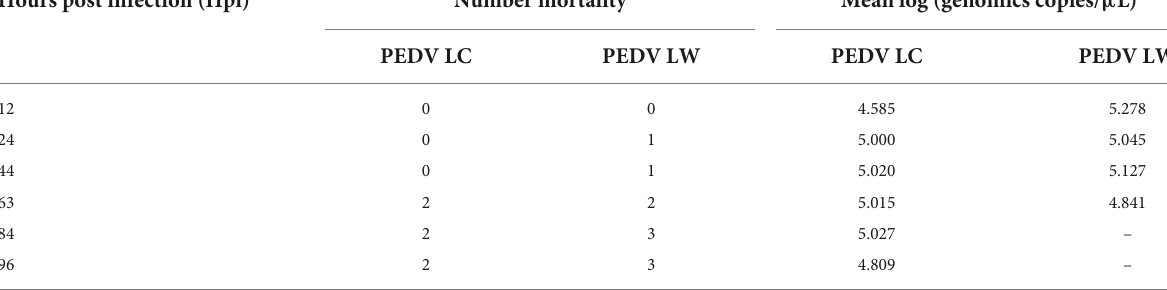
TABLE 5 Mortality and viral load of porcine epidemic diarrhea virus in feces. Hours post infection (Hpi)